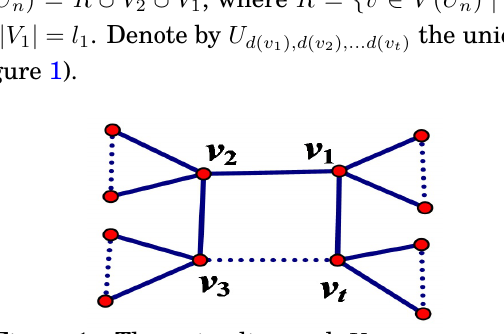
d ( v 1 ) ,d ( v 2 ) ,...d ( v t )